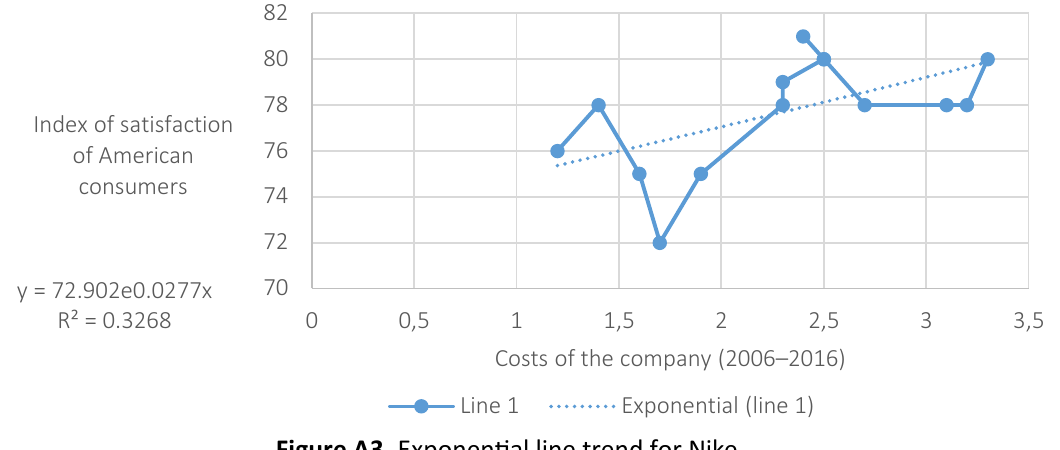
Figure A2. Polynomial line trend for Nike